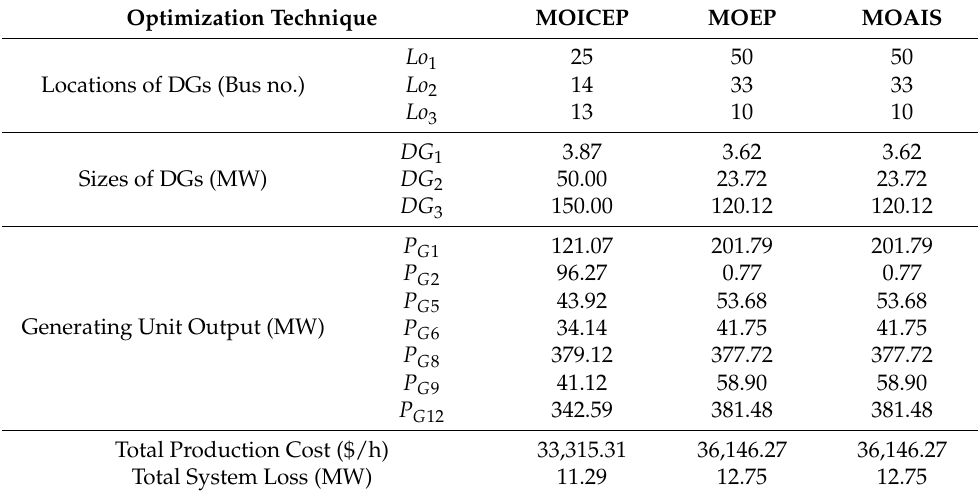
Table 11. Results of the integrated ED problem with prohibited operating zones and DG installation of the IEEE 57-Bus RTS ( w 1 = 0.9 and w 2 = 0.1). Optimization Technique MOICEP MOEP MOAIS Locations of DGs (Bus no.)